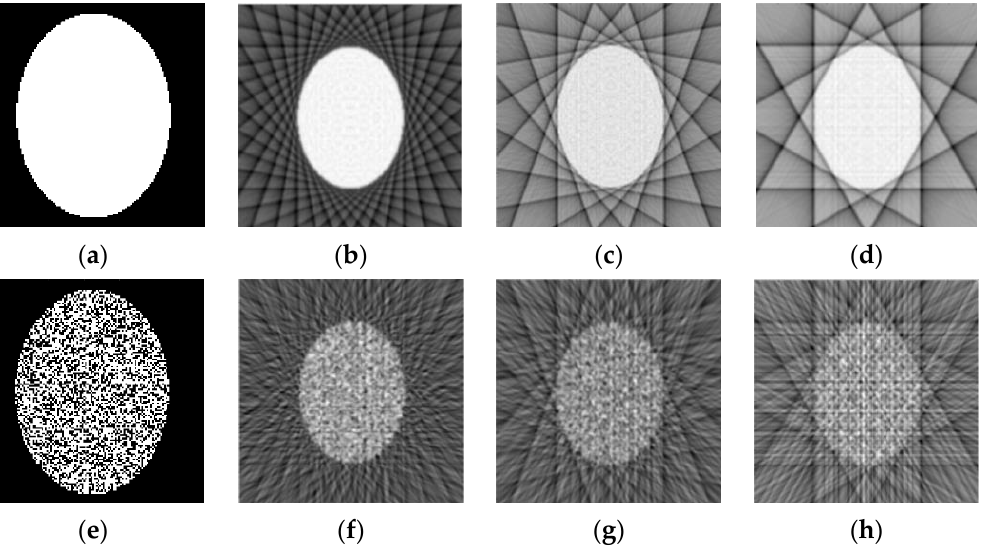
Figure 11. Examples of reconstruction of two ellipses, using their under-sampled parallel-beam sinograms by the back-projection algorithm with Hann filter. ( a ) Original ellipse; ( b – d ) Reconstructed images for 18, 9, and 6 projection angles, correspondingly; ( e ) Original strong noisy ellipse; ( f – h ) Reconstructed images for 18, 9, and 6 projection angles, correspondingly.